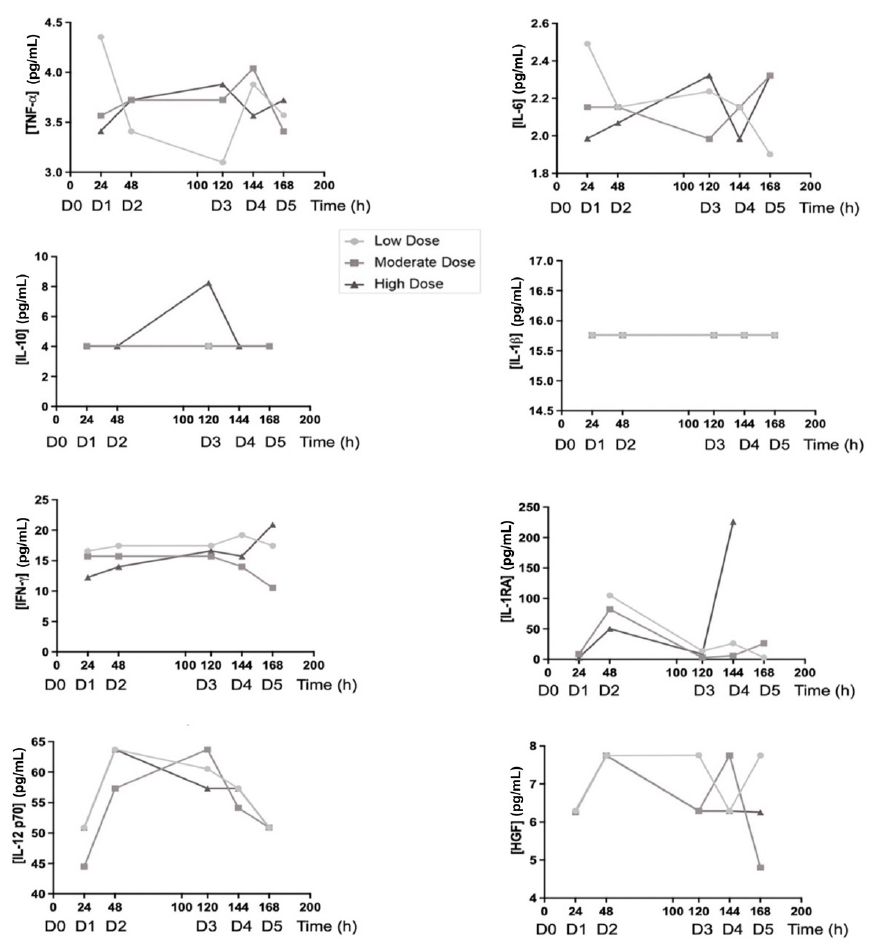
Figure 6. Analysis of human cytokines. Blood samples were extracted from 8 out of 15 mice from day 0 (before treatment) and from each one of them at their respective experimental point (see Methodology). Afterwards, their sera were used to quantify the levels of mouse HGF, TNF- α , IL-12 p70, IL-1 β , IL-6, IL-10, IFN- γ , and TIMP-1 by multiplex assays. D0–5 indicates the number of doses already administered to those mice at every time point. Time = 0 h is represented as the mean +/- SD from 8 samples. Supplementary information is available in Table S4: Values of human cytokines analyzed by multiplex assay.